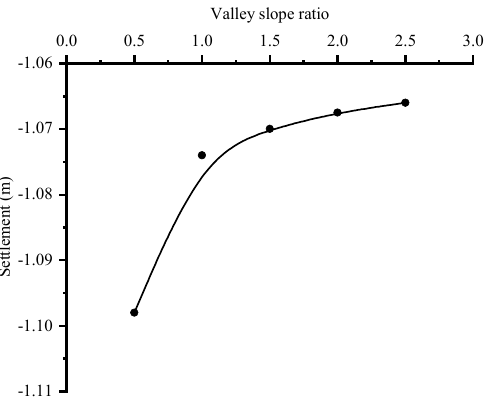
Table 3. Settlement, stress level, and shear safety factor of ACC with different valley slope ratios.